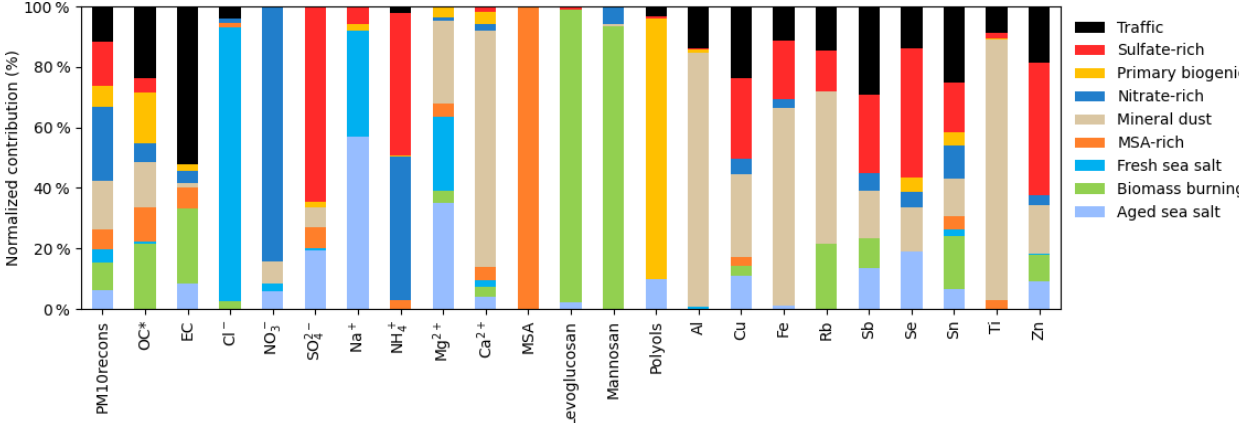
Figure 3. Species repartition by PMF-resolved sources at the OPE site.